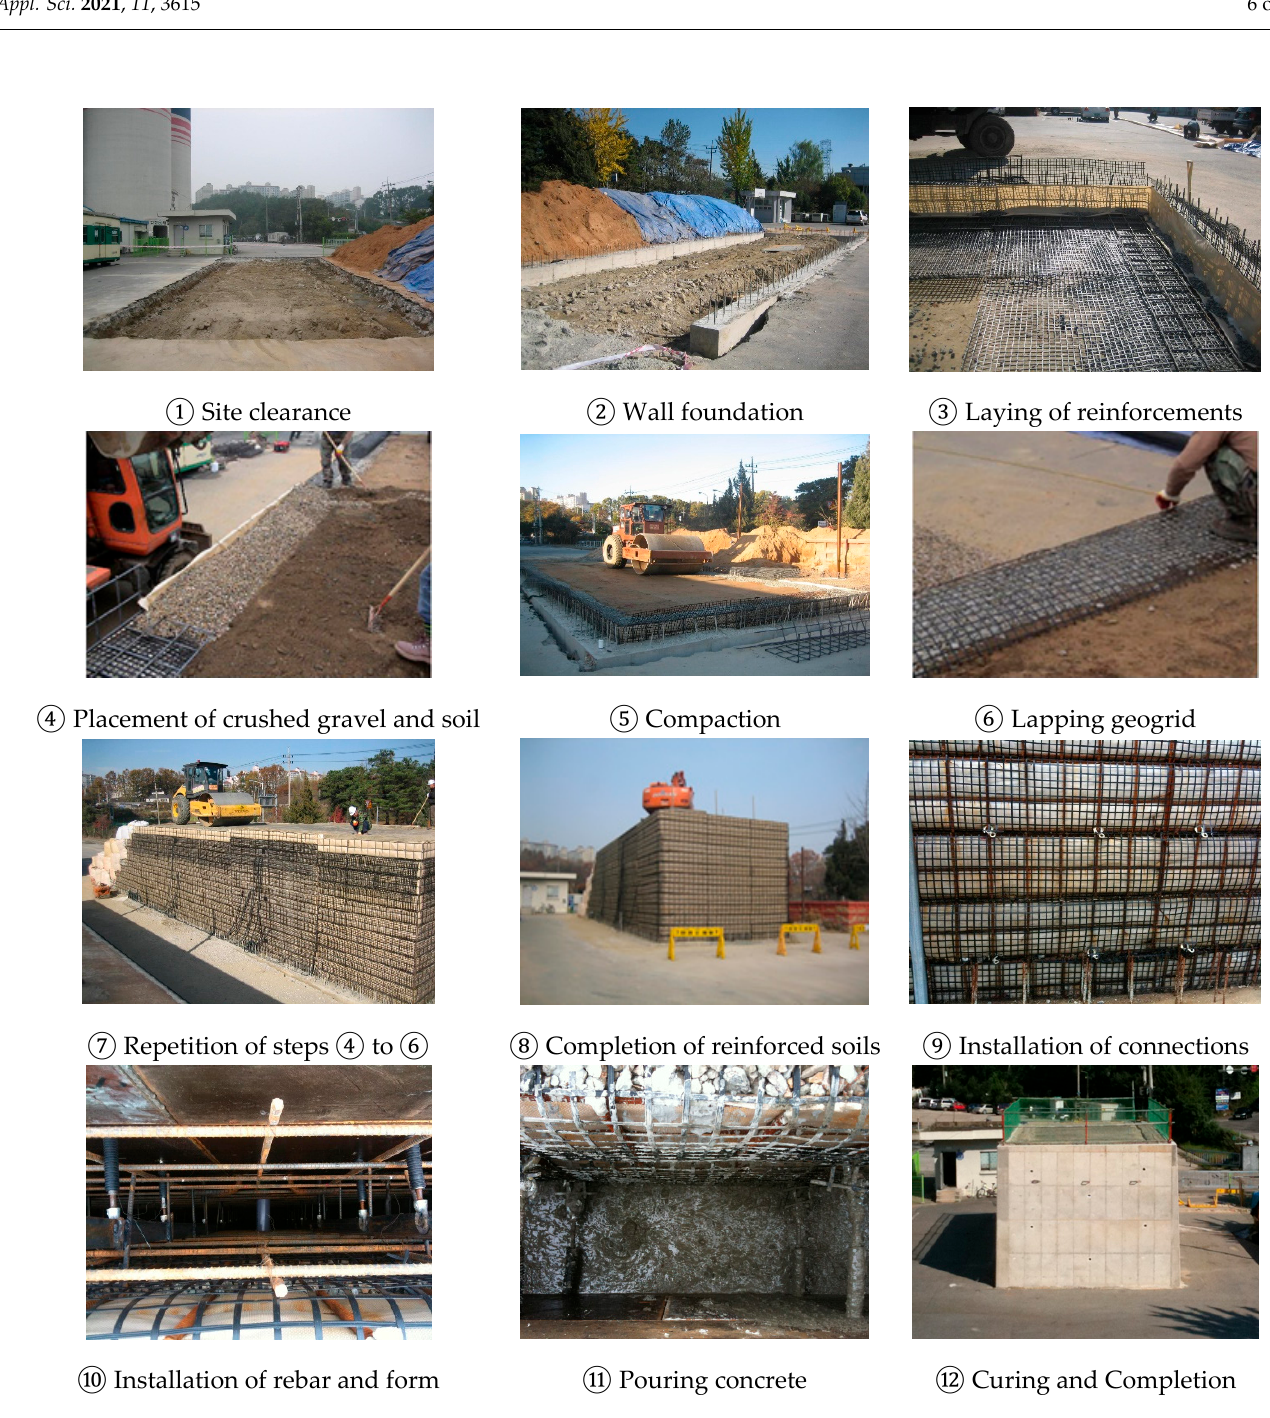
Figure 6. Construction procedures of RSR.